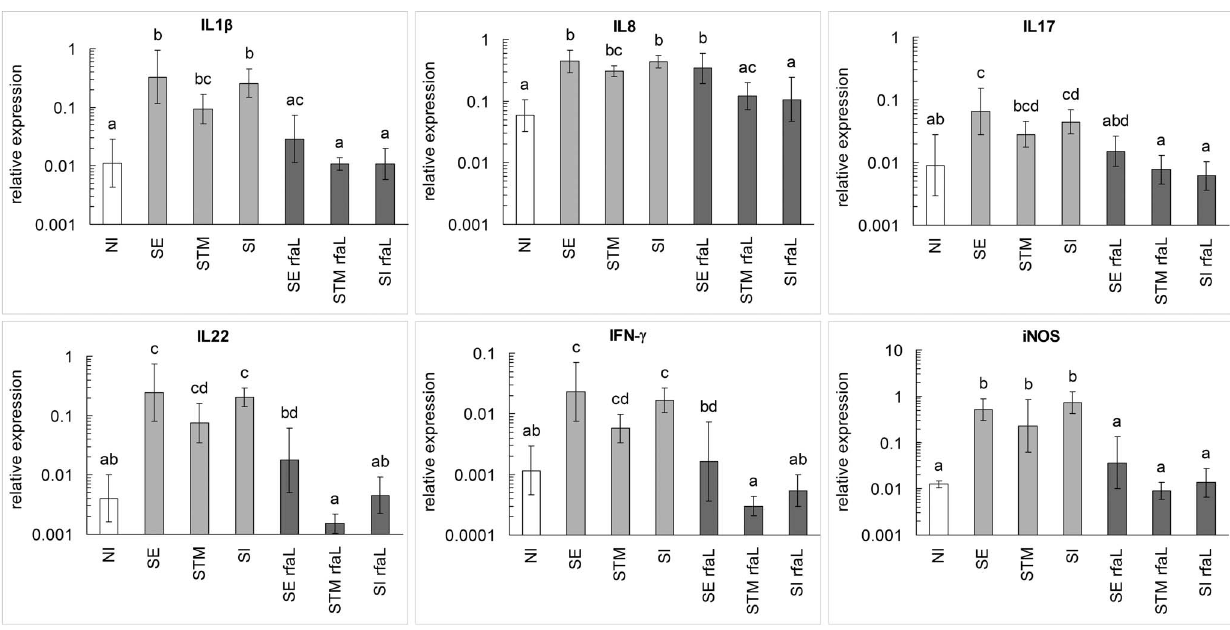
Figure 1. Cytokine gene expression in the cecum of orally infected chickens. Columns represent geometric means of the relative expressions of respective genes. Vertical bars represent 95% confidence intervals regarding the geometric means. Superscripts above columns denote statistically significant differences among groups (columns sharing the same superscript are not significantly different from each other, columns that have no superscript in common are significantly different from each other). NI, expression in the non-infected chickens. SE, expression in the chickens infected with S . Enteritidis 147. STM, expression in the chickens infected with S . Typhimurium LT2. SI, expression in the chickens infected with S . Infantis 1516. SE rfaL , expression in the chickens infected with S . Enteritidis rfaL mutant. STM rfaL , expression in the chickens infected with S . Typhimurium rfaL mutant. SI rfaL , expression in the chickens infected with S . Infantis rfaL (I) mutant. Mind logarithmic scaling of Y-axis.